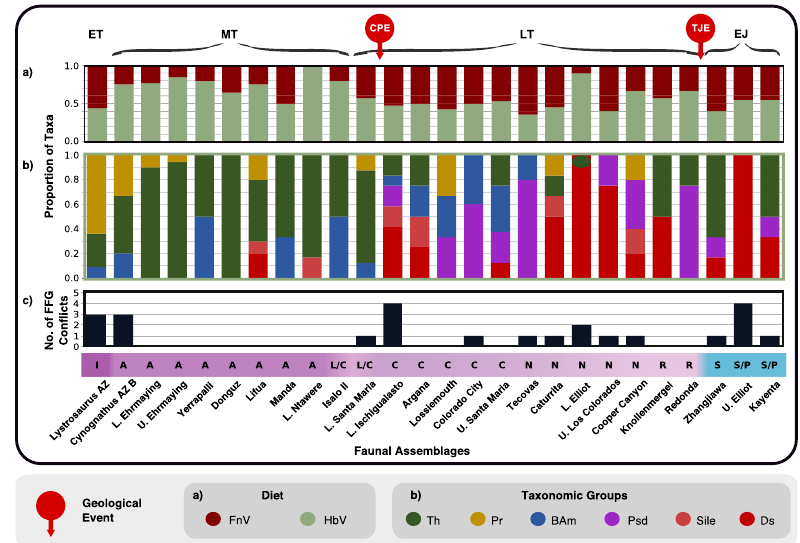
Fig. 4 Relative faunal abundances and potential competitive trophic con fl icts within early Mesozoic assemblages through time. a The relative abundance of faunivores and herbivores. b The relative species richness of different therapsids and sauropsid clades. c The number of feeding functional group (FFG) con fl icts in each assemblage. AZ Assemblage Zone, L Lower, No Number, Geological Events: CPE Carnian Pluvial Event, TJE Triassic-Jurassic mass extinction, Epochs: EJ Early Jurassic, ET Early Triassic, LT Late Triassic, MT Middle Triassic, Timebins: A Anisian, C Carnian, I Induan, L/C Ladinian/ Carnian, N Norian, R Rhaetian, S Sinemurian, S/P Sinemurian/Pliensbachian, Diet: FnV Faunivores, HbV Herbivores, Taxonomic groups: BAm Basal Archosauromorpha, Ds Dinosauria, Pr Parareptilia, Psd Pseudosuchia, Sile Silesauridae, Th